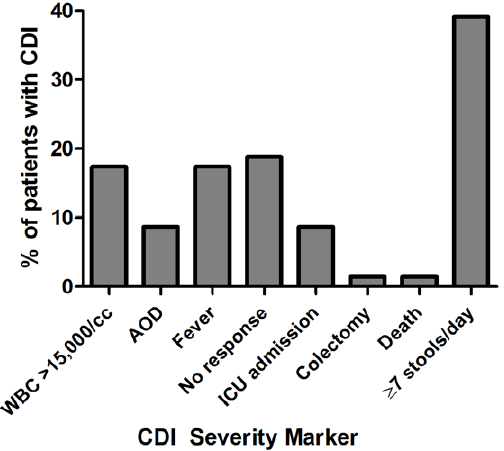
Figure 3. Percent of patients with a CDI severity marker. This bar graph illustrates that having $ seven stools per day had a much higher prevalence than other severity markers in our cohort. ( WBC : white blood cell; AOD : acute organ dysfunction; ICU : intensive care